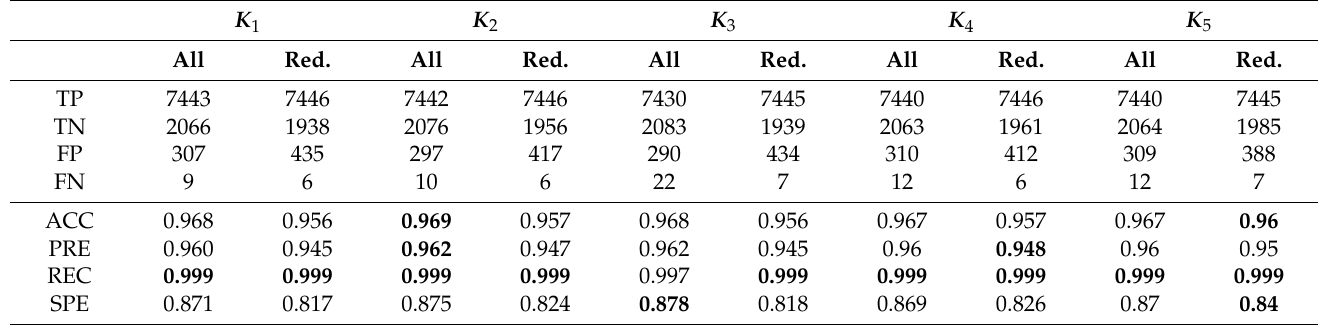
Table 2. Confusion and classification evaluation metrics with the operator K used in the FRSystem, where All and Red. means test on full and on reduced set of rules. respectively.